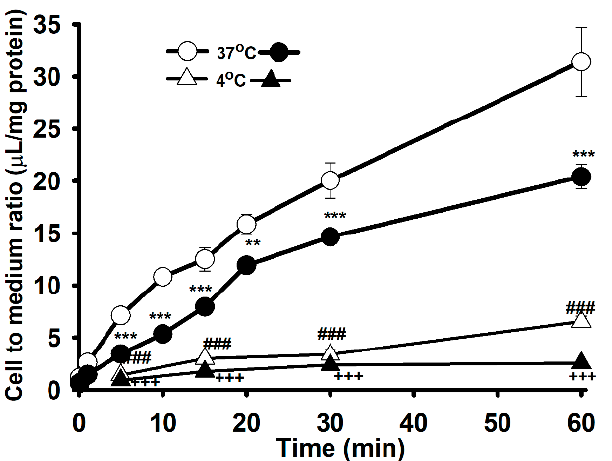
Figure 1. Time and temperature dependent uptake of [ 3 H]L-carnitine (32.5 nM) in NSC-34 cell lines. The uptake was monitored from 1 to 60 min at 37 °C and 4 °C under physiological pH. Open circles ( ο ) and triangle ( Δ ) represent the wild type (WT, NSC-34hSOD1 wt ), and closed circles ( ● ) and triangle ( ▲ ) denotes the mutant type (MT, NSC-34 hSOD1 G93A ). Each point represents the mean ± S.E.M ( n = 3–4). *** p < 0.001, ** p < 0.01 and ### p < 0.001 indicate significant differences from the WT 37°C, and +++ p < 0.001 represents significant difference from MT 37 °C.